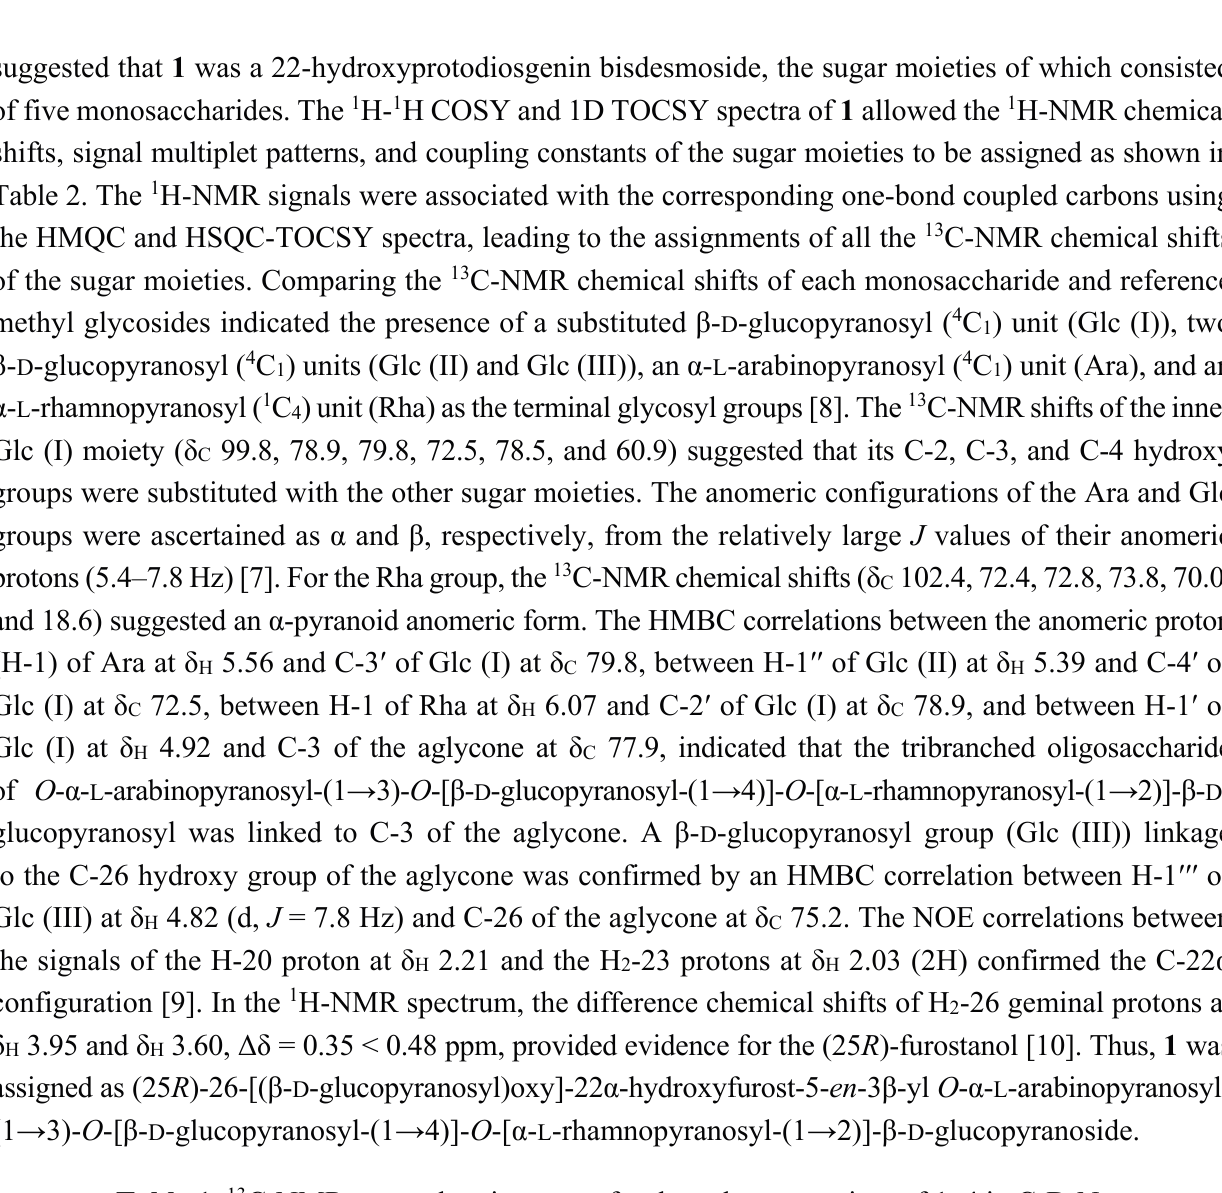
Table 1. 13 C-NMR spectral assignments for the aglycone moiety of 1 – 4 in C 5 D 5